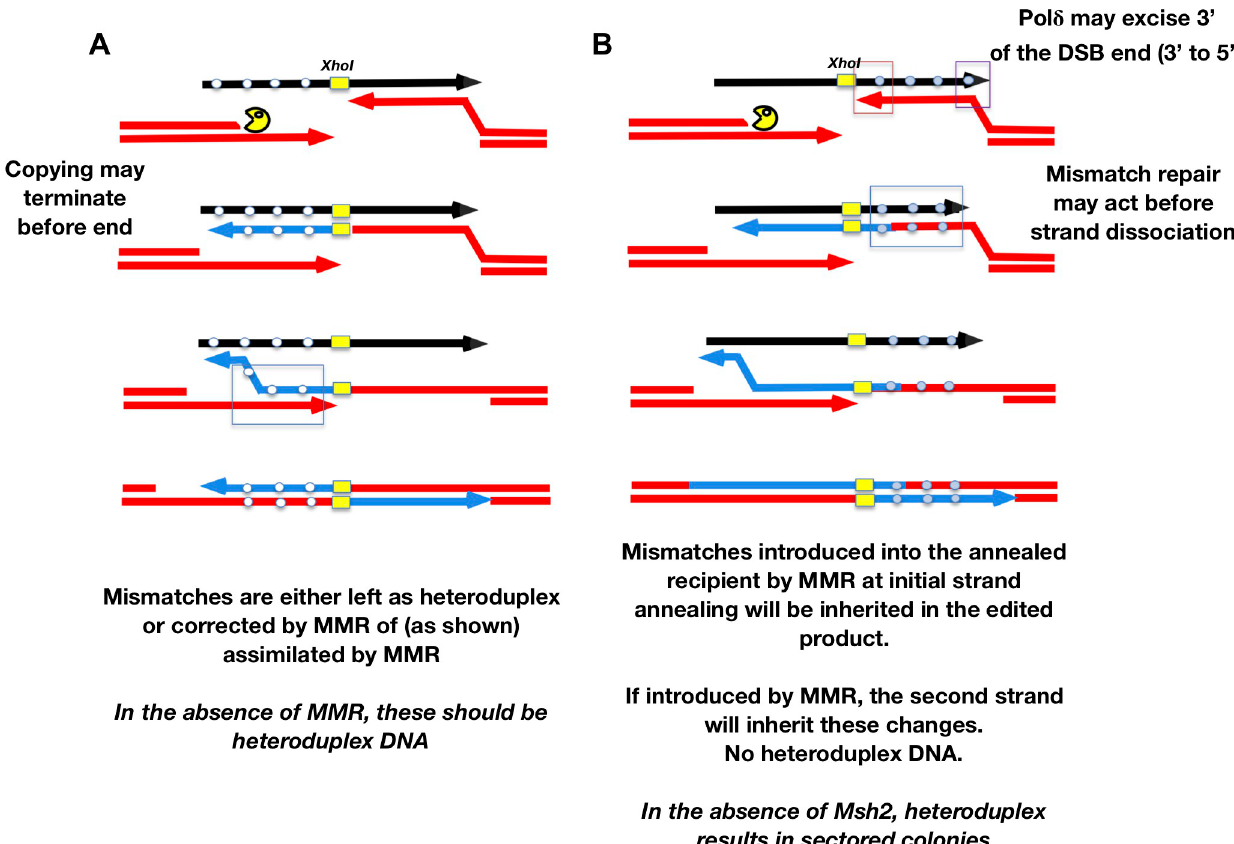
Fig 7. Model of heteroduplex formation and incorporation of mismatches during SSTR. Fate of an ssODN with 4 mismatches either 5’ to the Xho I site (A) or 3’ (B). After the DSB is created and resected only the strand on the right can anneal to the template. This annealing creates a heteroduplex that may be repaired by the mismatch repair machinery including Msh2. Heterologies close to the 3’ end of the invading strand, but also at the 3’ end of the ssODN, can be excised by the 3’ to 5’ exonuclease activity of DNA polymerase δ . Only if the heteroduplex is converted to the template strand genotype will these mismatches be incorporated into the SSTR product (B). Mismatches 5’ to the Xho I site will be obligately copied by DNA polymerase after strand invasion (A). The dissociation of the newly copied strand allows it to anneal with the resected second end of the DSB, creating an obligate heteroduplex. Dissociation of the newly copied strand may occur without copying the end of the ssODN template. Heteroduplex DNA may then be corrected to the genotype of the donor template or left as unrepaired heteroduplex. In the absence of Msh2, most outcomes will have heteroduplex to the left of the Xho I site but no incorporation to the right, resulting in sectored